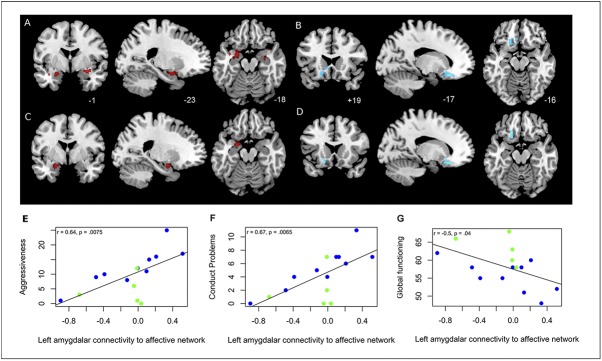
Disrupted affective network connectivity in ADHD compared to healthy controls.Group comparisons of the affective network at baseline (dataset 1) show increased left amygdalar connectivity (A) and decreased left orbitofrontal cortex connectivity (B) in children with ADHD compared to healthy control children. Similar significant group-wise findings were observed in a subset of 10 ADHD children three months later compared to healthy subjects (C, D). E-G brain-behavior scatterplots: The increased left amygdalar connectivity in ADHD children correlated with increased scores of aggressiveness (E) and conduct problems (F). The correlation between left increased amygdalar connectivity and lower general functioning is also depicted (G). Children with the ADHD combined subtype (both inattention and impulsive) are labeled blue while children with ADHD inattention subtype are labeled green.